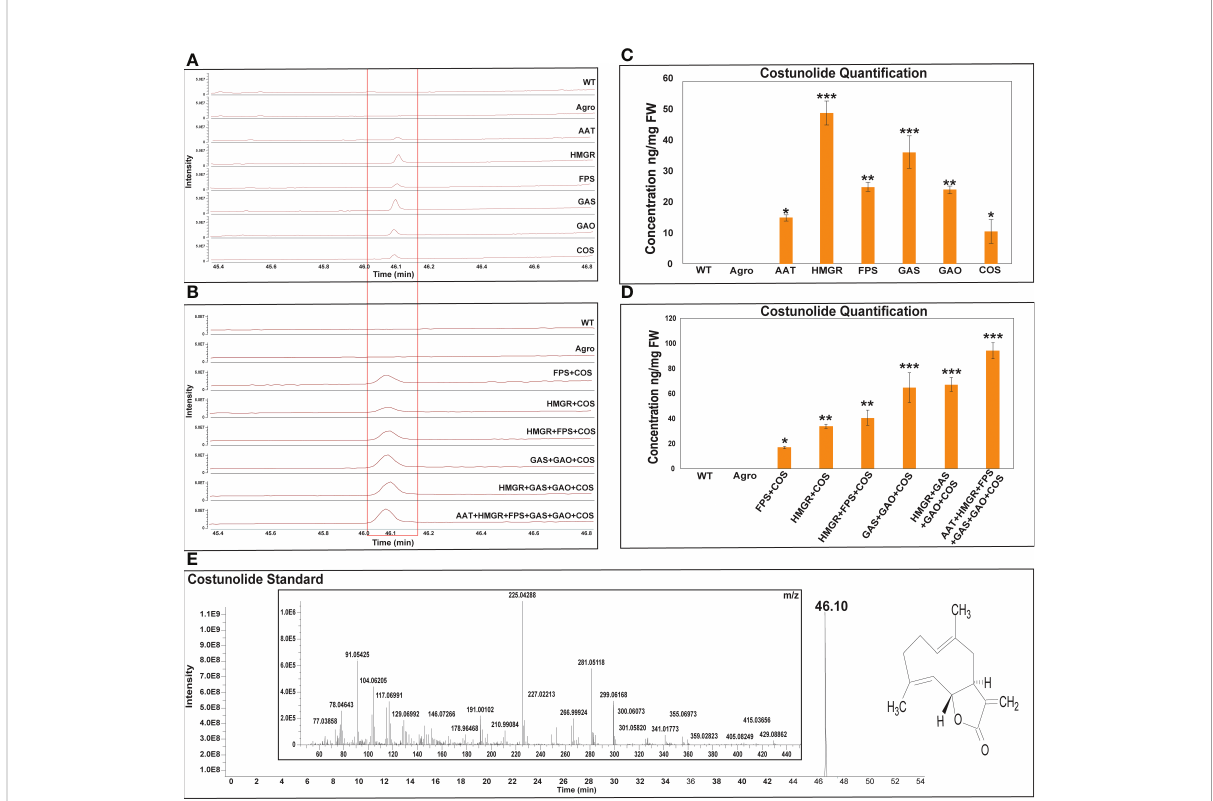
FIGURE 5 GC-Q-Oribtrap-MS costunolide pro fi ling and quanti fi cation for individual and combinatorial approaches. (A, B) Individual and combinatorial costunolide metabolite pro fi ling. (C, D) Individual and combinatorial costunoilde quanti fi cation. (E) Costunolide standard metabolite pro fi ling and m/z ions. Quanti fi cation of each bar represents the mean ± standard deviation (SD) of three independent experiments with three technical replicates. Statistical analyses (t-test) were conducted using SigmaPlot 12.5. For t-test analysis, the wild type values were used for construct comparisons. * indicates signi fi cant differences compared with the wild-type (*p < 0.05, **p < 0.01, ***p <